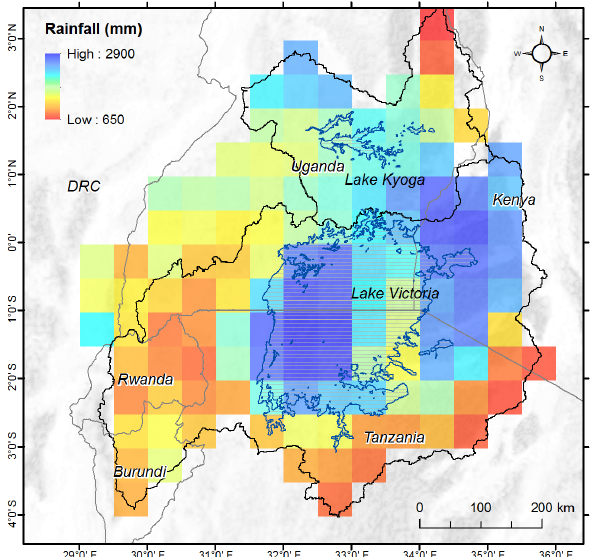
Figure 3. Mean annual rainfall for the period of 2003–2012 derived from TRMM satellite observations. Greater annual rainfall is ob- served over much of Lake Victoria and the north-eastern corner of the Lake Victoria Basin.